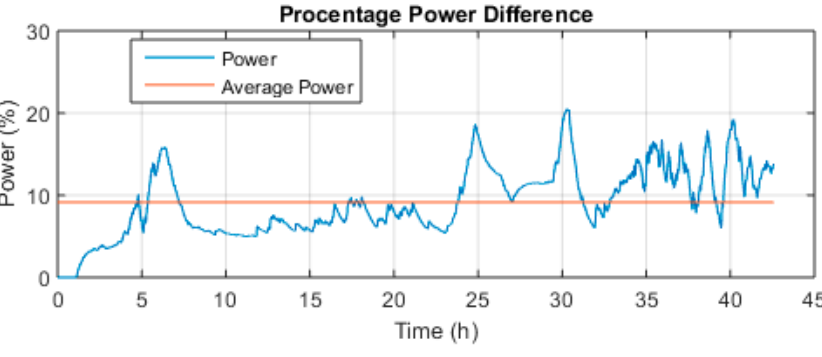
Figure 10. Percentage power difference after using FDC.